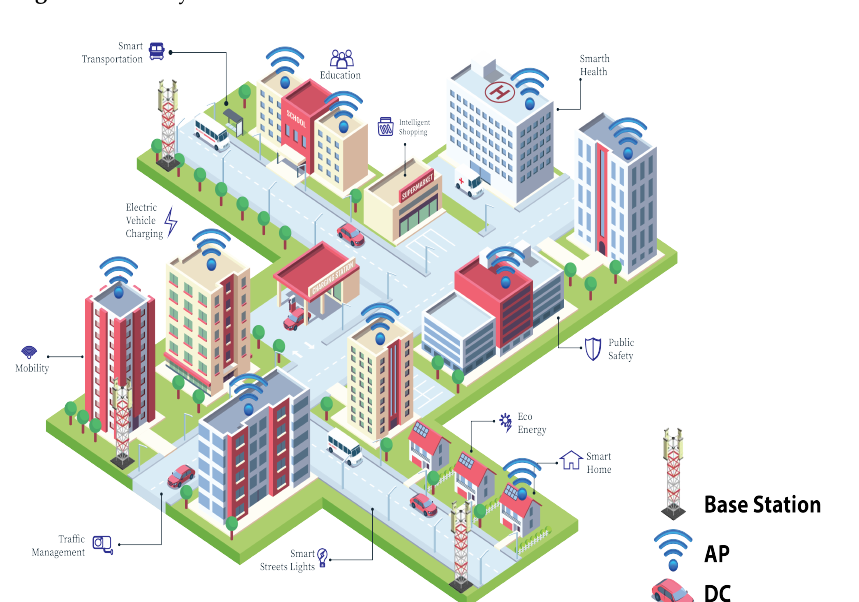
Figure 1. Two-layer architecture.